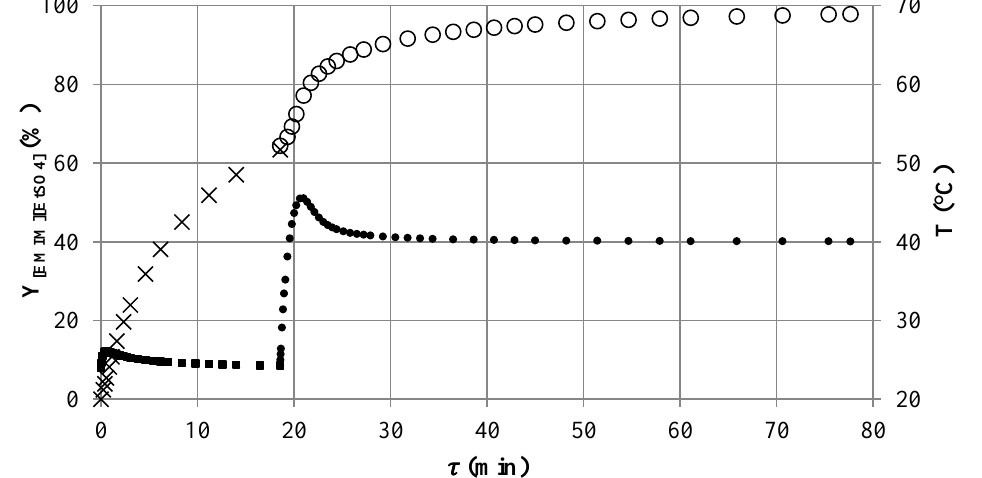
] in reactor setup SMX 8 (1,3) 4